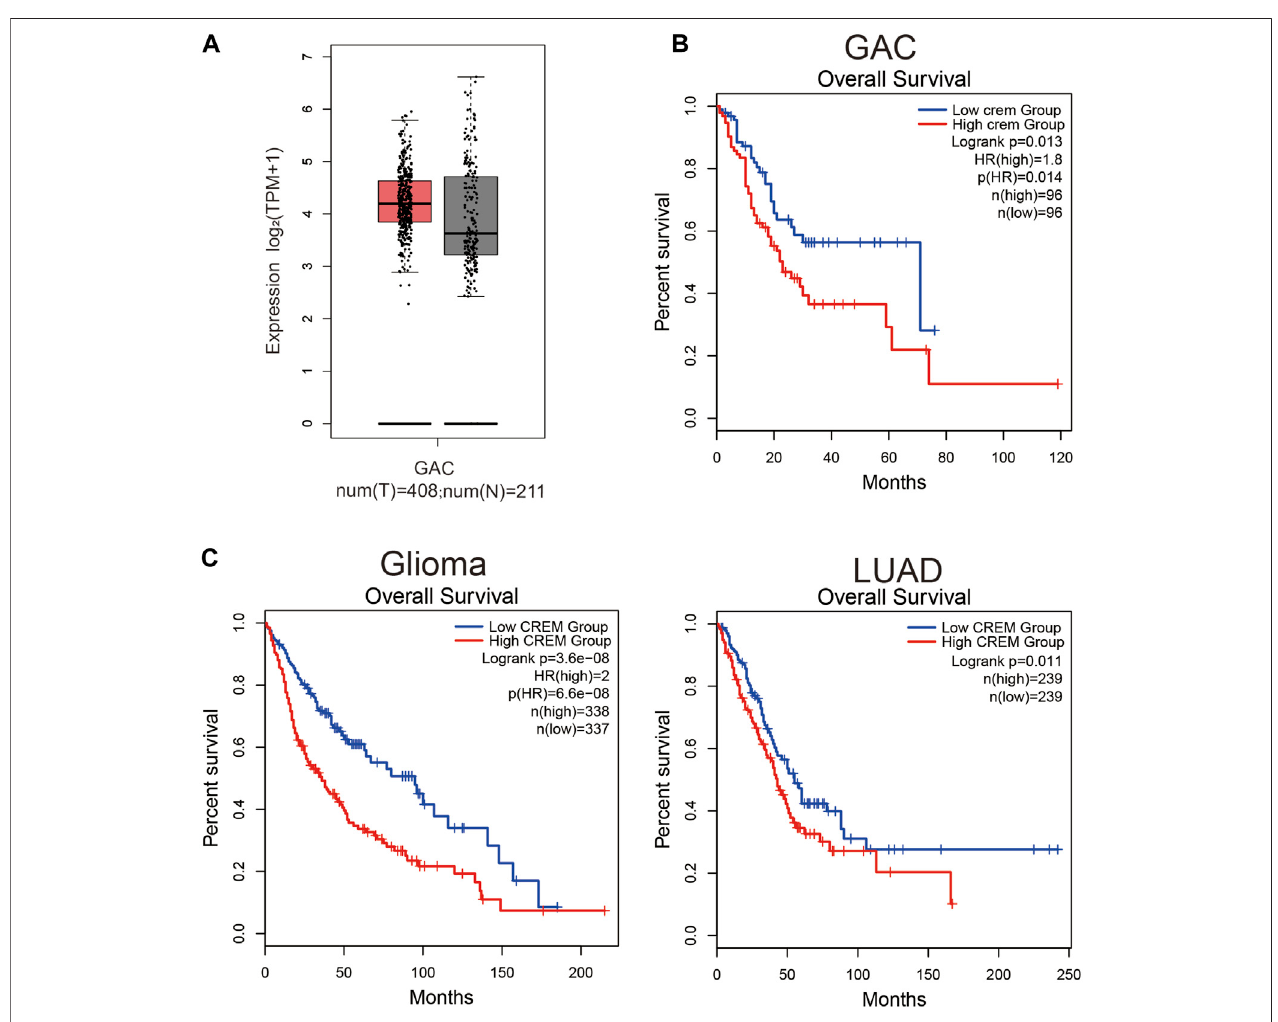
FIGURE 1 | Expression level analysis of CREM in GAC tissues. Kaplan – Meier survival curves comparing the high and low expression of CREM in different types of cancer in GEPIA2. (A) CREM expression level between tumor samples and normal samples in GAC. (B) Kaplan – Meier survival curves comparing high and low CREM expression groups in the GAC dataset. (C) Kaplan – Meier survival curves comparing high and low CREM expression groups in the glioma, LUAD dataset.